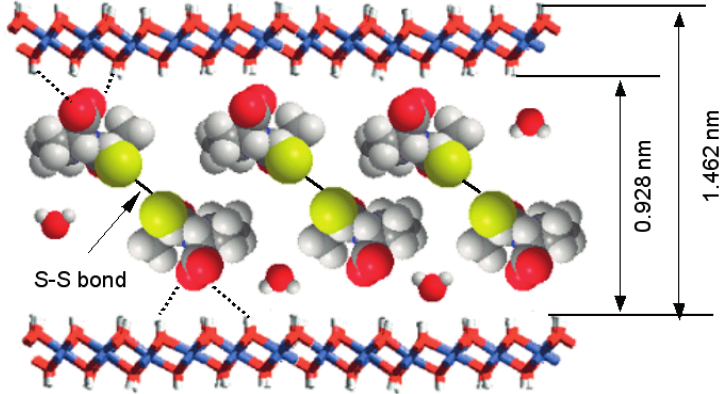
Figure 4. Supramolecular structural model of Cpl–LDH. Reprinted with permission from [58] (Copyright 2006